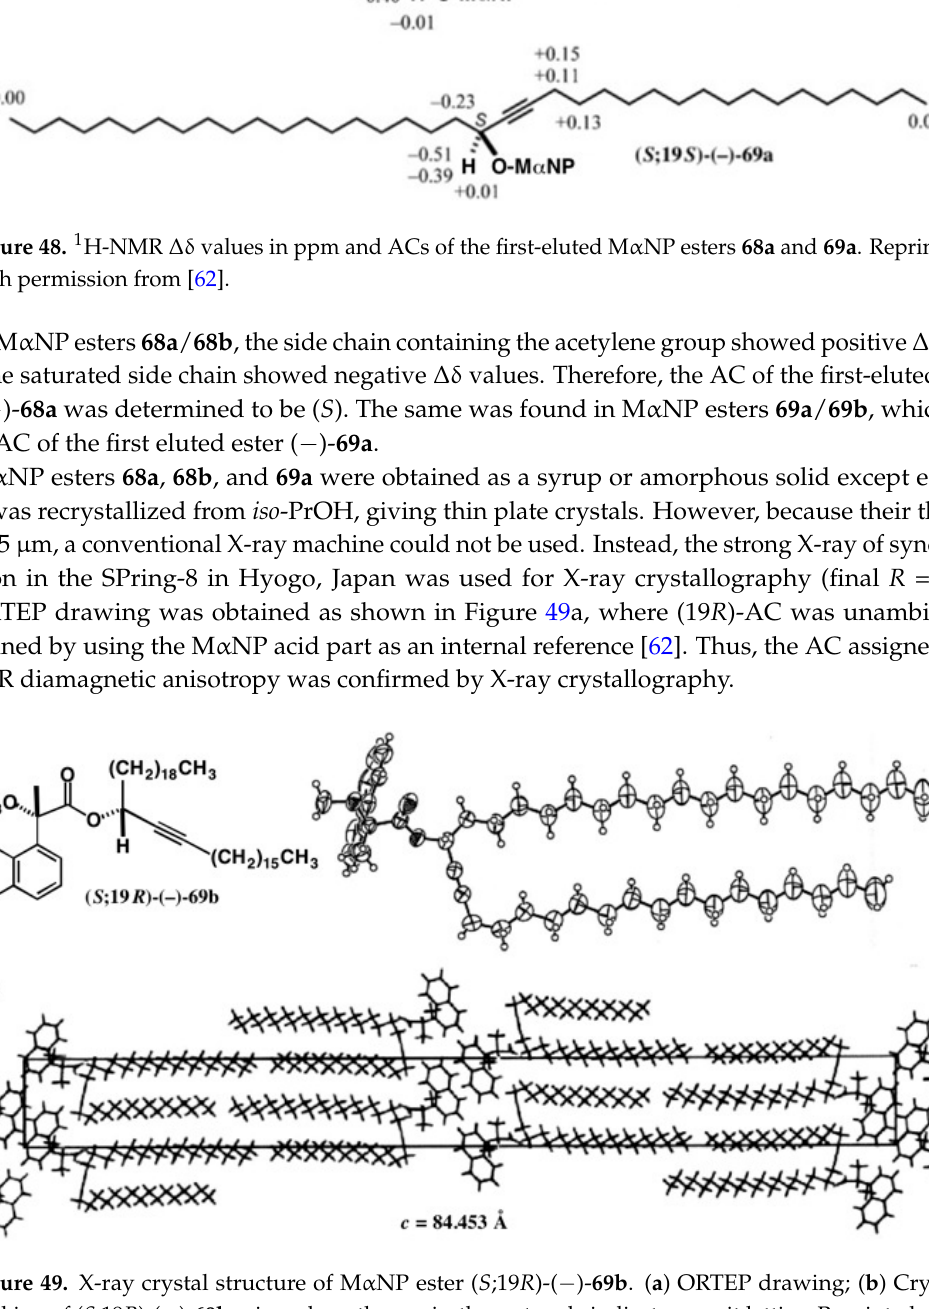
Figure 48. 1H-NMR ∆ δ values in ppm and ACs of the first-eluted M α NP esters 68a and 69a . Reprinted with permission from [62].